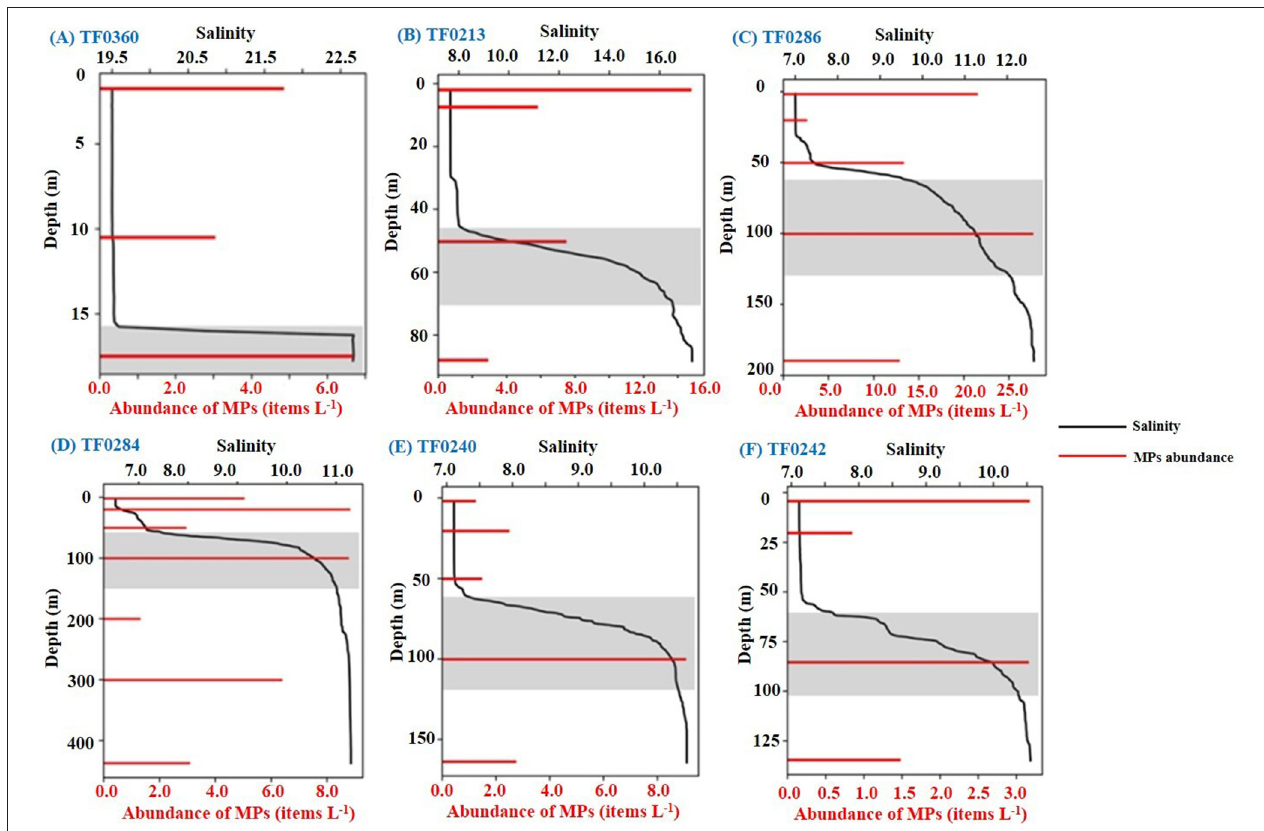
FIGURE 4 | Changes in microplastic abundance with salinity over depth in the water column at different stations (A–F) . Shadows in the figure indicate the locations of the halocline in the corresponding water column and their microplastics abundance. “MPs” refers to microplastics. The Y -axis represents sampling depth (m), the X -axis of the top (in black) represents the salinity, and the X -axis of the bottom (in red) represents microplastics abundance (items L − 1 ).